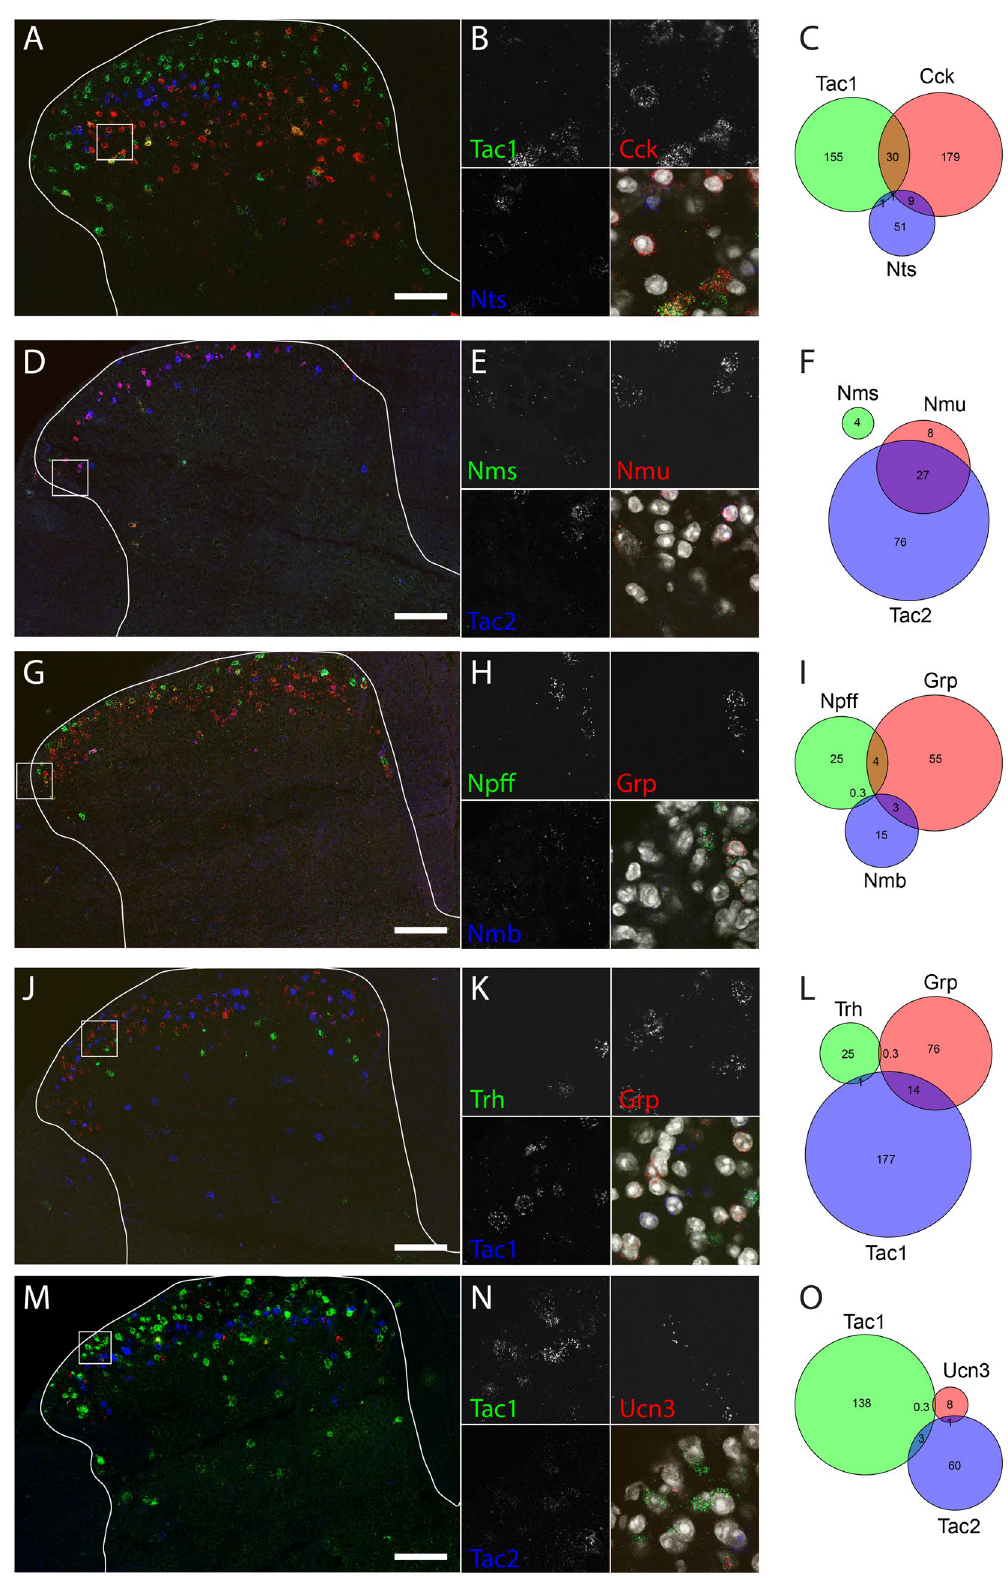
Figure 5. Multiplex in situ hybridization shows co-expression of eleven neuropeptides. Five combinations of three neuropeptides each: ( A – C ) Tac1 , Cck and Nts ; ( D – F ) Nms , Nmu and Tac2 ; ( G – I ) Npff , Grp and Nmb ; ( J – L ) Trh , Grp and Tac1 ; ( M – O ): Tac1 , Ucn3 and Tac2 in green, red and blue, respectively. ( A , D , G , J , M ) Overview images over the lumbar dorsal horn. The outline of the gray matter is indicated. Scale bar 100 μm. Box indicates position of the higher magnification image in ( B , E , H , K , N ). ( C , F , I , L , O ) Number of cells per animal (two hemi-sections) that (co-)express the three neuropeptides. Circle and intersection sizes are approximately proportional to the cell number they